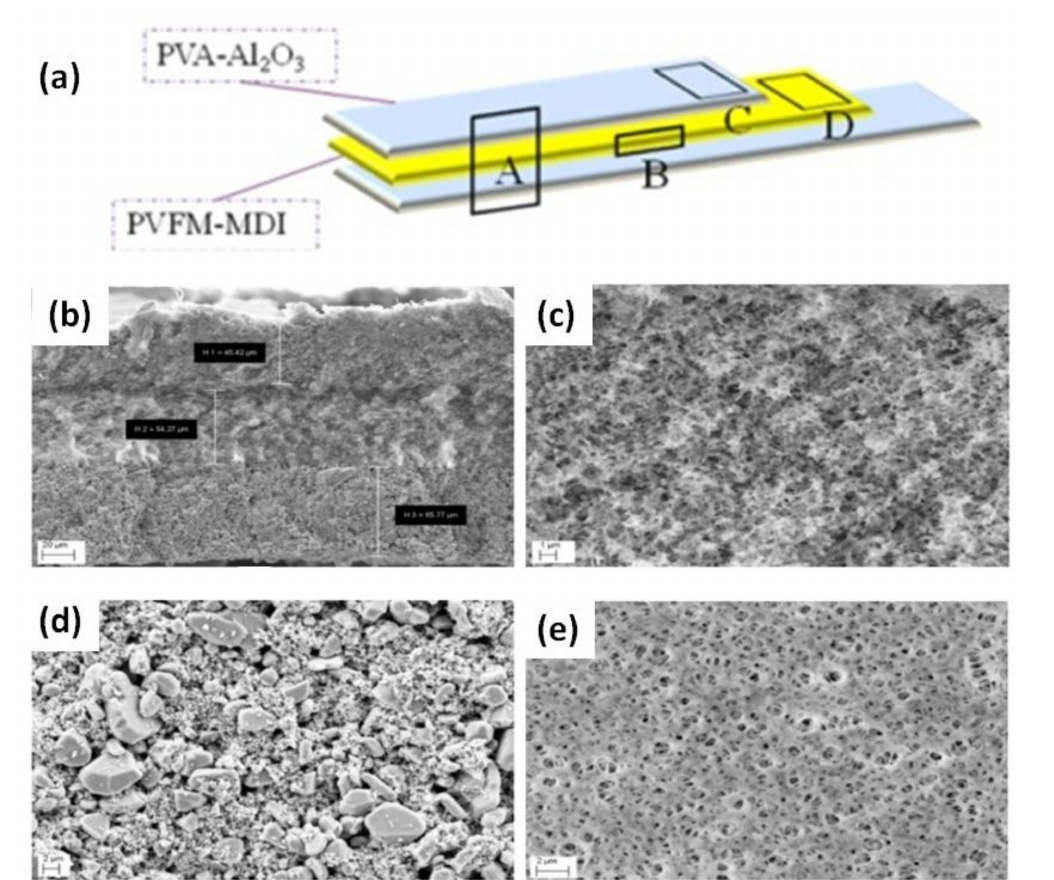
Figure 10. ( a ) Schematic of the membrane (Al 2 O 3 /PVFM/Al 2 O 3 ). SEM images of the trilayer membrane; ( b ) cross-sectional image of the trilayer membrane; ( c ) cross-sectional image of the PVFM membrane; ( d ) the surface morphology of the Al 2 O 3 coating layer; and ( e ) the surface morphology of the PVFM-based membrane. Reprinted with permission from Wen et al. [99]. Copyright 2007 Scientific Research Publishing Inc.